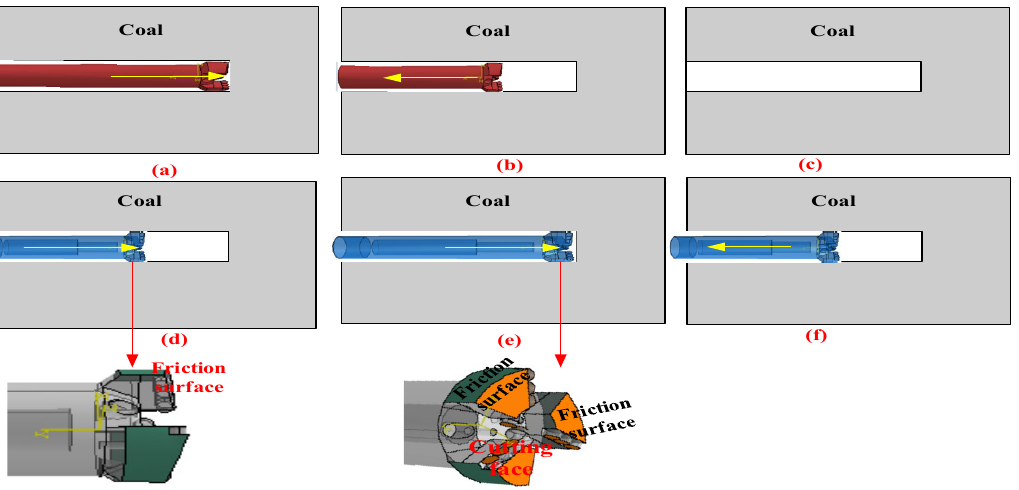
Figure 7. Diagram of coring process: the yellow arrow represents the movement direction of the core tube: ( a ) the process of drilling hole; ( b ) withdrawing the drill pipe; ( c ) formation of the hole; ( d ) the process of pushing core tube; ( e ) drilling the coal core sample and ( f ) withdrawing the core tube.